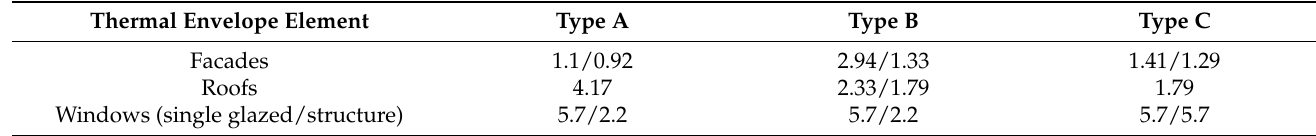
Table 2. Thermal transmittance, U (W/m 2 K), of construction elements in thermal envelope of representative school buildings in their initial state